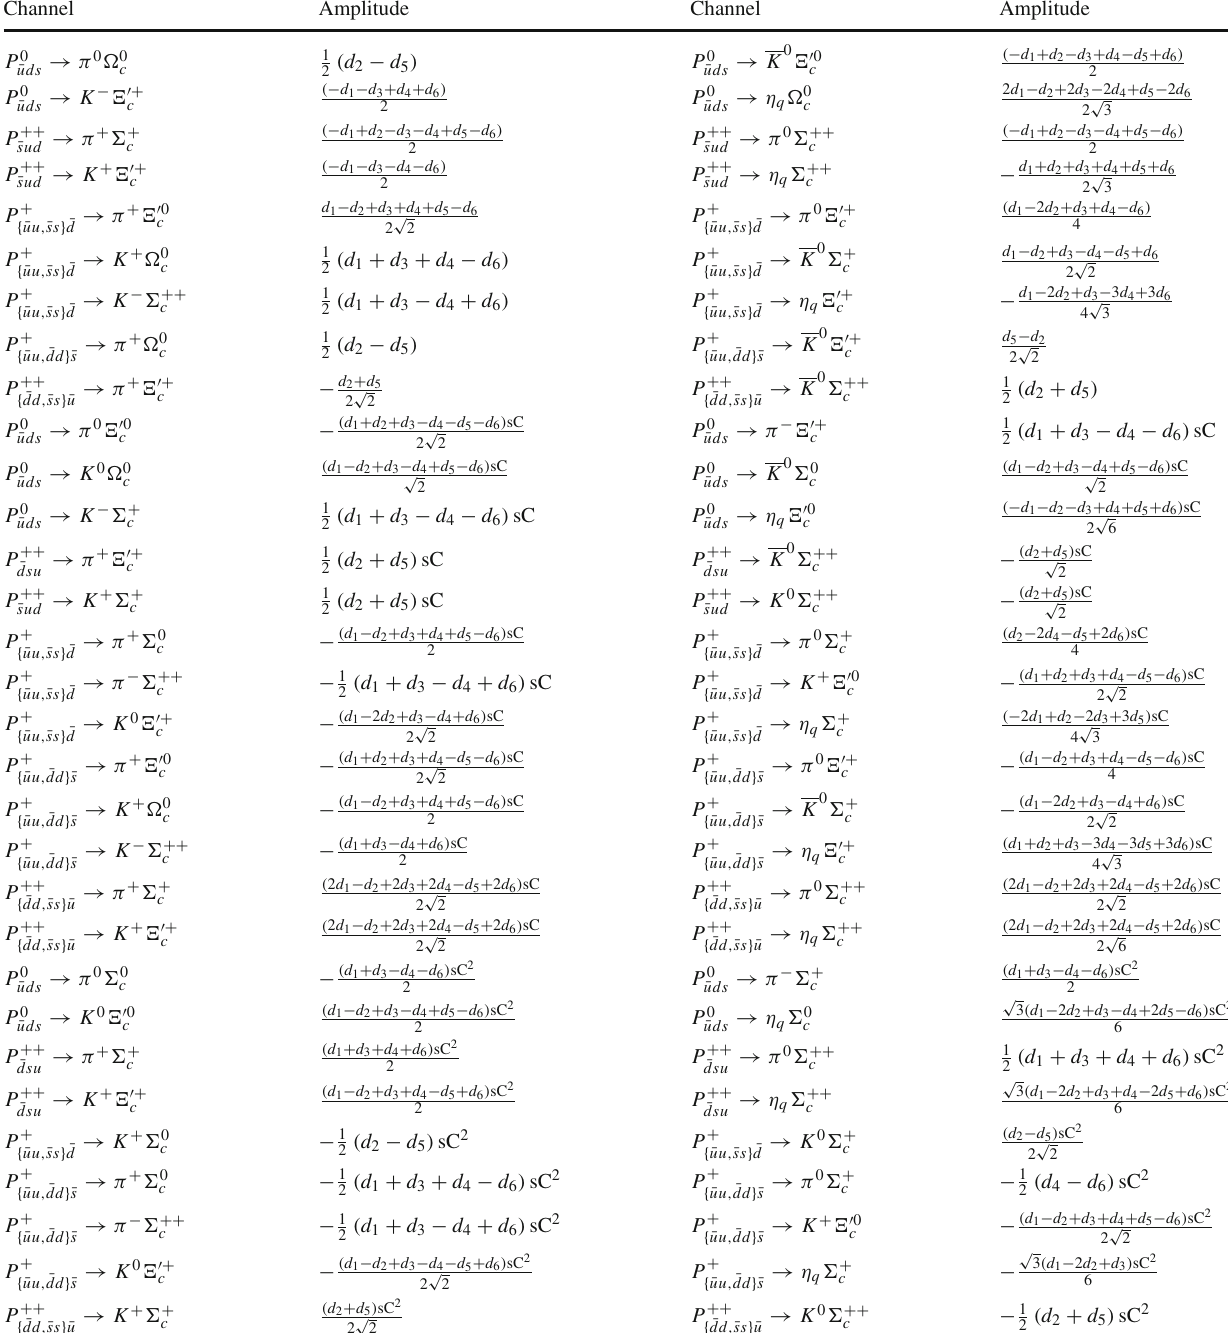
Table 7 Pentaquark P 6 ( cc ¯ qqq ) decays into light mesons and singly charmed baryons sextet with Cabibbo allowed, the singly Cabibbo suppressed and doubly Cabibbo suppressed Channel Amplitude Channel Amplitude → π 0 (cid:2) 0 P 0 ¯ uds